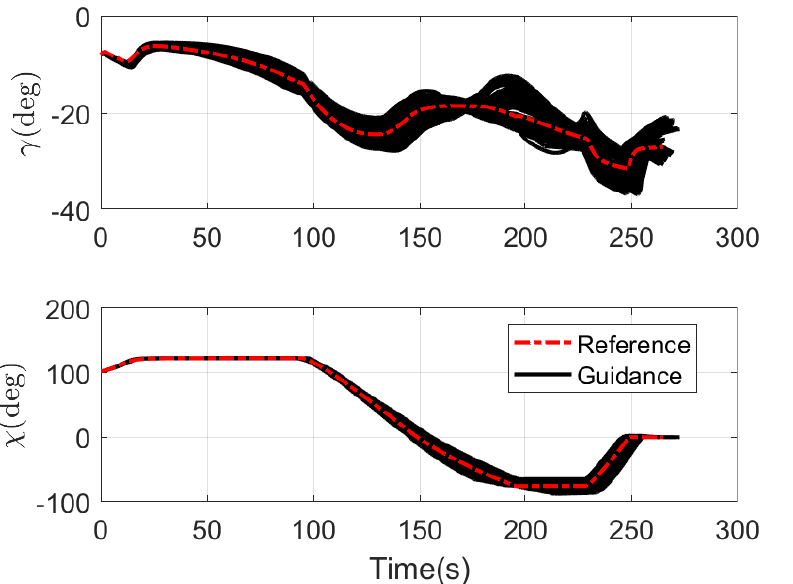
Figure 5. Flight path angle and heading angle profiles with respect to time in Monte Carlo simulation.